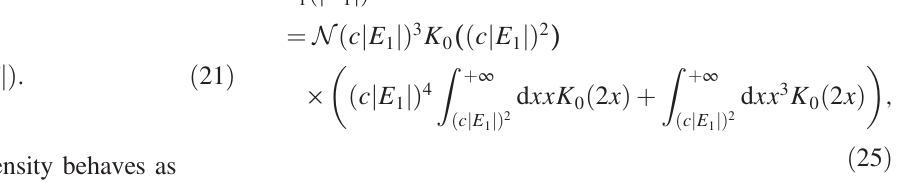
FIG. 13. Distribution of the eigenvalue with the smallest absolute value j E 1 j for the chiral nHSYK model Eq. (19) with q ¼ 4 and N ¼ 22 , 26 and about 50 000 disorder realizations. We find excellent agreement with the random matrix prediction for the AIII † universality class, obtained by diagonalization of 10 7 , 100 × 100 matrices. The analytical surmise [Eq. (25), black] is also very close to the numerical results. We note that the comparison is